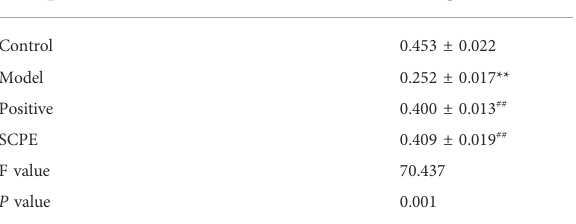
TABLE 3 Effect of SCPE on the new object recognition experiment of D-galactose model mice (mean ± SD, n = 15).